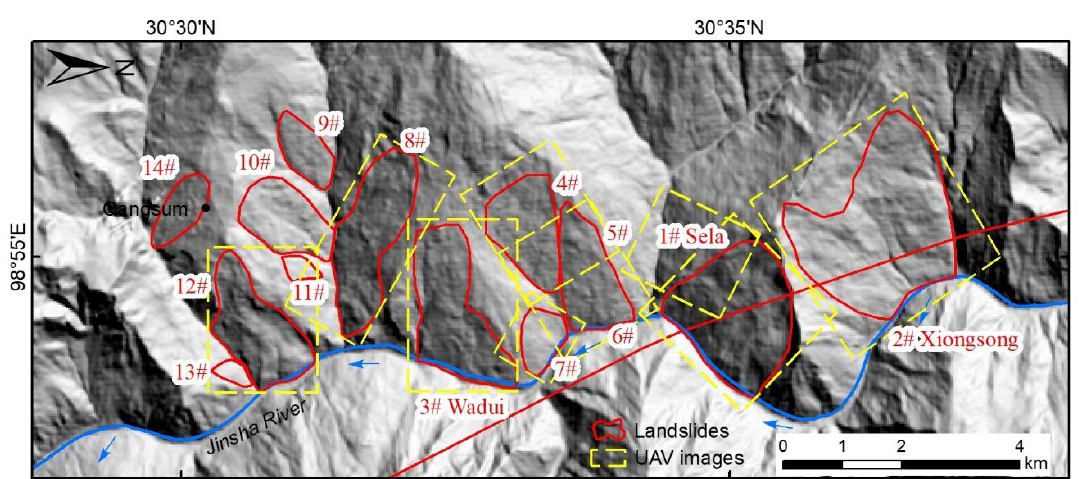
Figure 2. Areas covered by UAV images. Different numbers labeled the landslide.